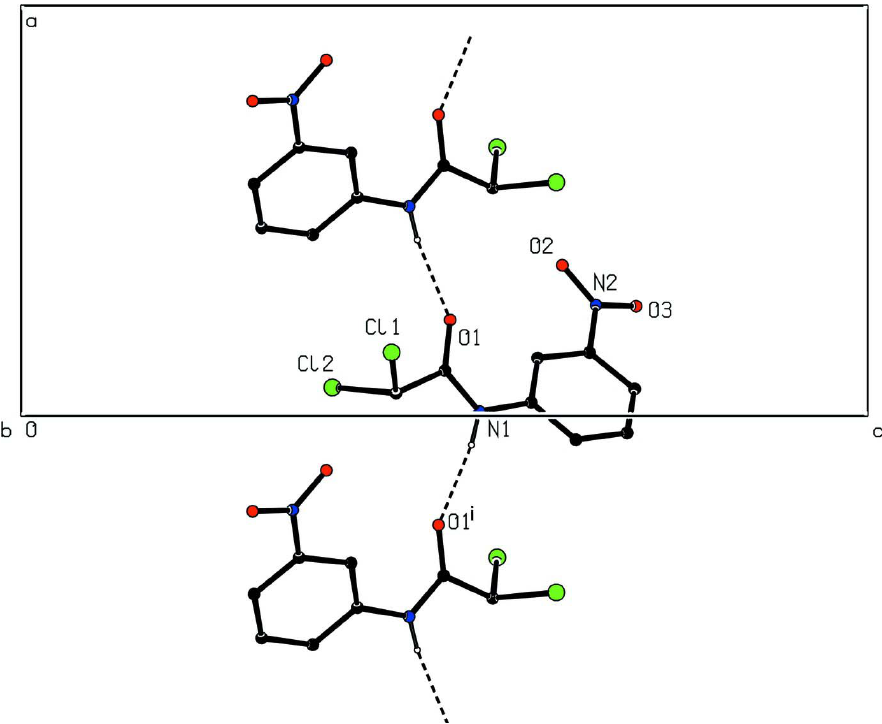
Figure 2 Partial packing view showing the hydrogen bonding as dashed lines.H atoms not involved in hydrogen bonding have been omitted for clarity. [Symmetry code: (i) x - 1/2, 1/2 - y ,1 - z